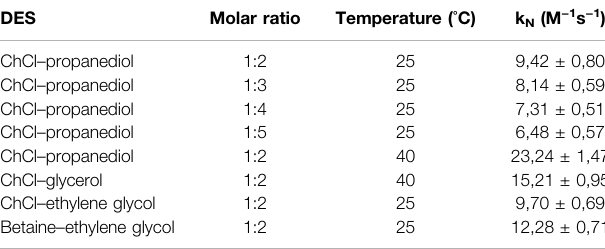
TABLE 5 | Nucleophilic reaction rates for the reaction between 2,4,5-trinitro phenyl phenyl ether and piperazine in DES. DES Molar ratio Temperature ( ° C) ChCl – propanediol